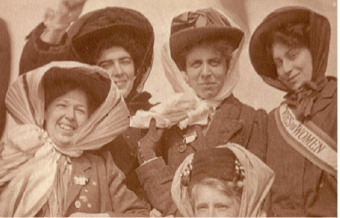
Figure 4. Jack Holme is in the front on the left with other members of the WSPU in 1909, Women’s Library, LSE, London.